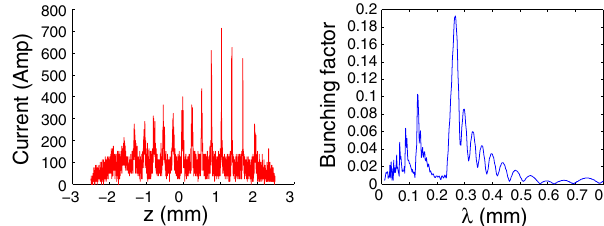
FIG. 9. Density profile of the pulse at 100 MeV and bunching factor.